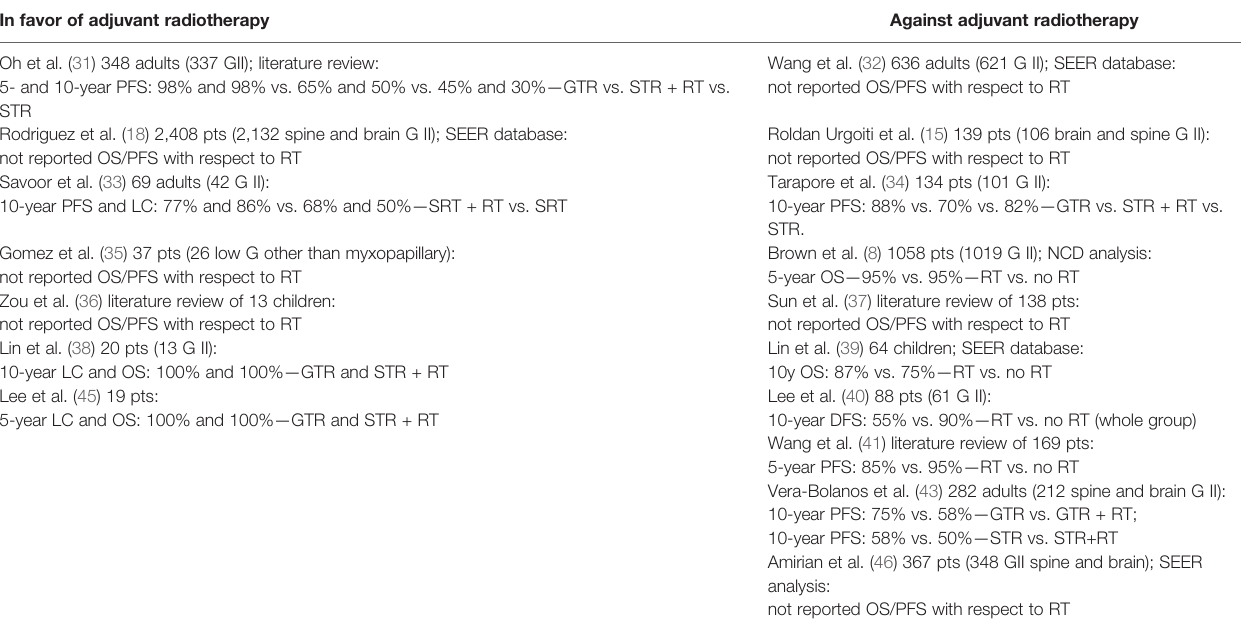
analysis: not reported OS/PFS with respect to